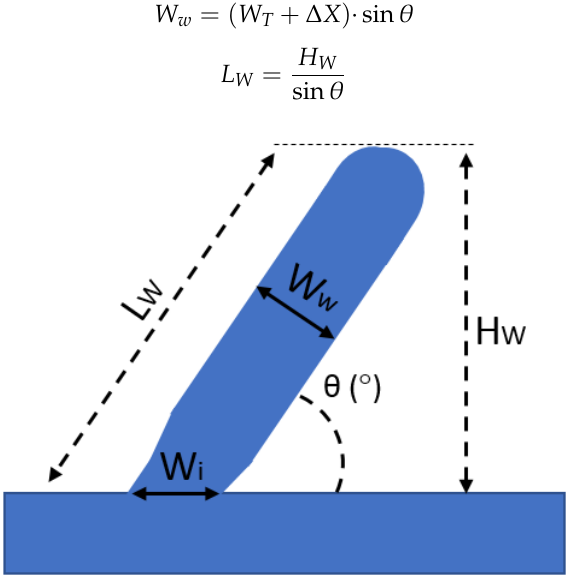
Figure 6. Geometric dimensions of the wall.